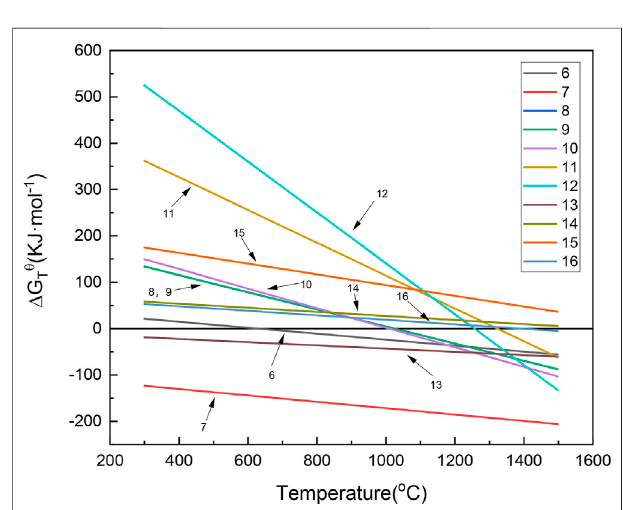
FIGURE 5 | Effect of H 2 ratio on (A) nickel and (B) iron enrichment. Experimental conditions: pre-calcination, 450 ° C, 60 min; temperature, 1000 ° C; reduction time, 90 min; fl ow rate of H 2 /N 2 , 27 L/(min kg); grinding fi neness, 85 wt% passing 0.074 mm; magnetic fi eld intensity, 0.156 T.